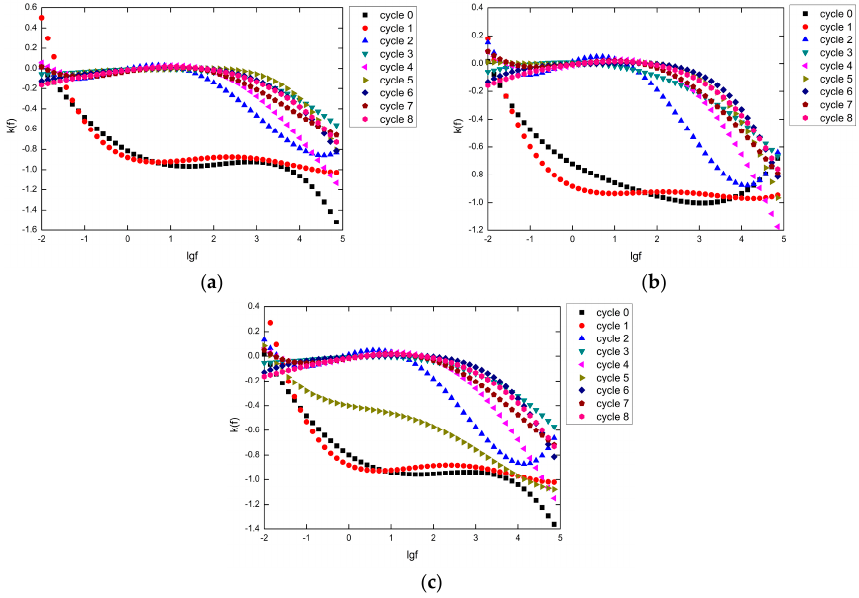
Figure 11. The changing rate in impedance k : ( a ) Plate 1#; ( b ) Plate 2#; ( c ) Plate 3#.